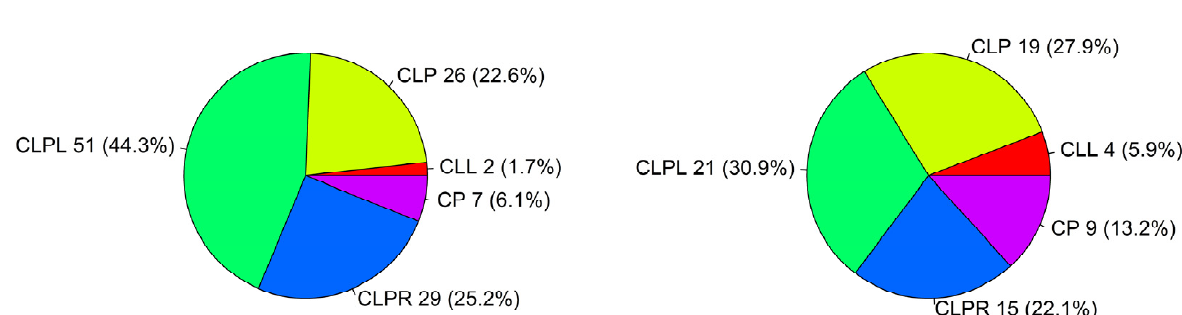
Figure 1. Distribution of cleft type by sex.